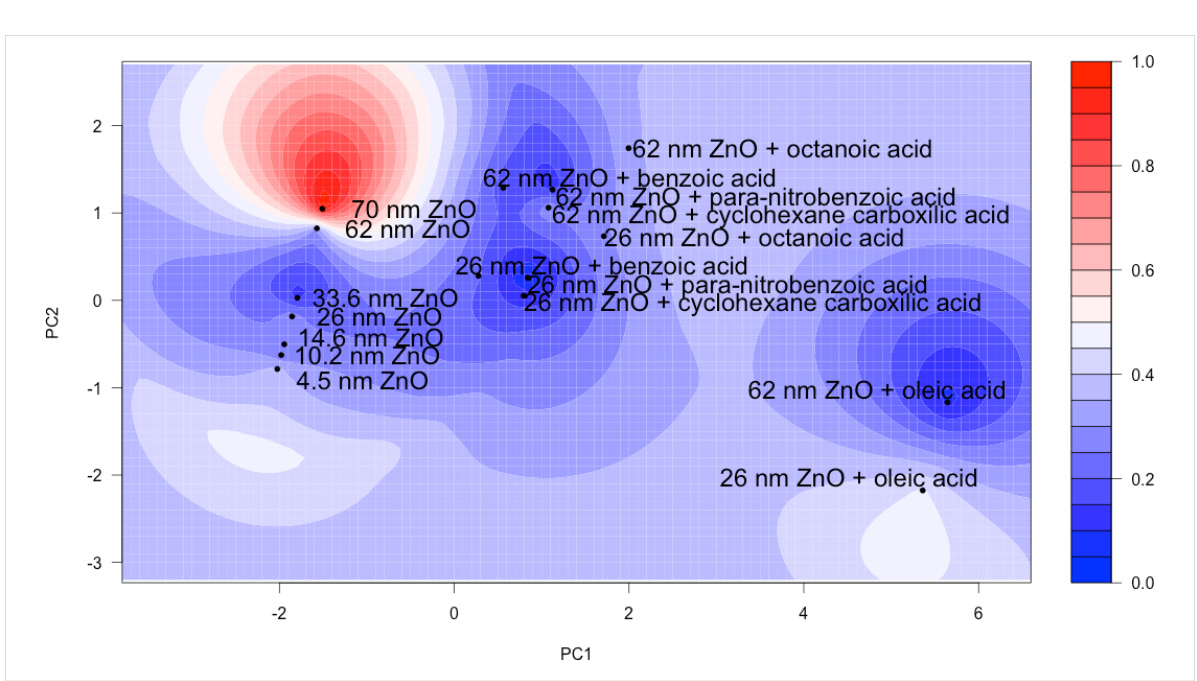
Figure 5: Clustering analysis based on Euclidian distance for ZnO NPs partitioned into 3 clusters. Shown on the left (blue hash marks) are the bare ZnO NPs with the blank control point. In the middle (tan hash marks) are ZnO NPs with 4 different surface chemistries and on the right are the oleic acid modified particles.